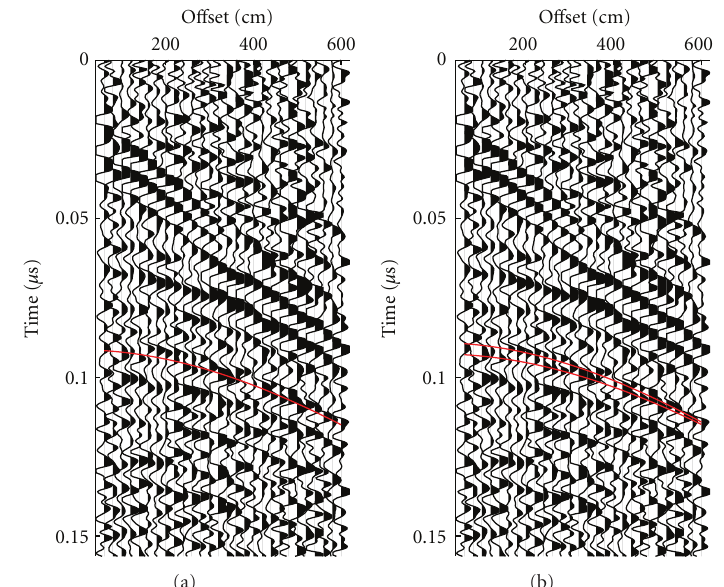
Figure 12: CMP gather superimposed the hyperbolic moveouts (red curves) for the interfering events based on semblance (a) and SB- MUSIC